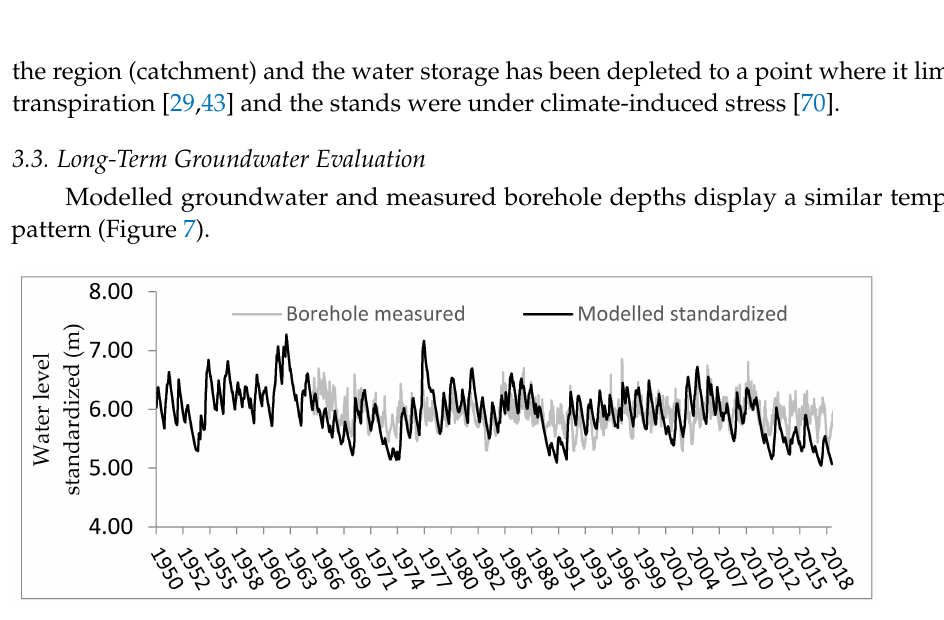
Figure 7. Borehole measured depth and modelled depth to groundwater based on PERSiST simulated groundwater